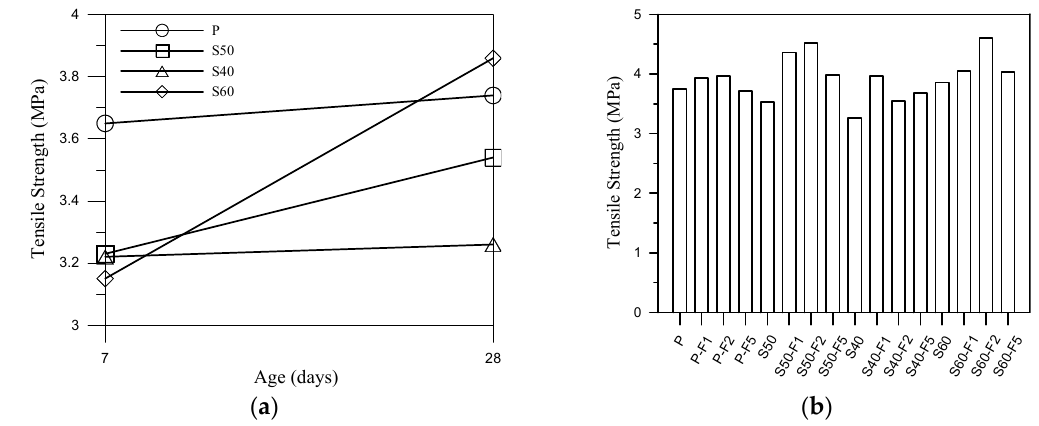
Figure 5. ( a ) Tensile strength development curves of select samples and ( b ) tensile strength results of all samples at 28 days.